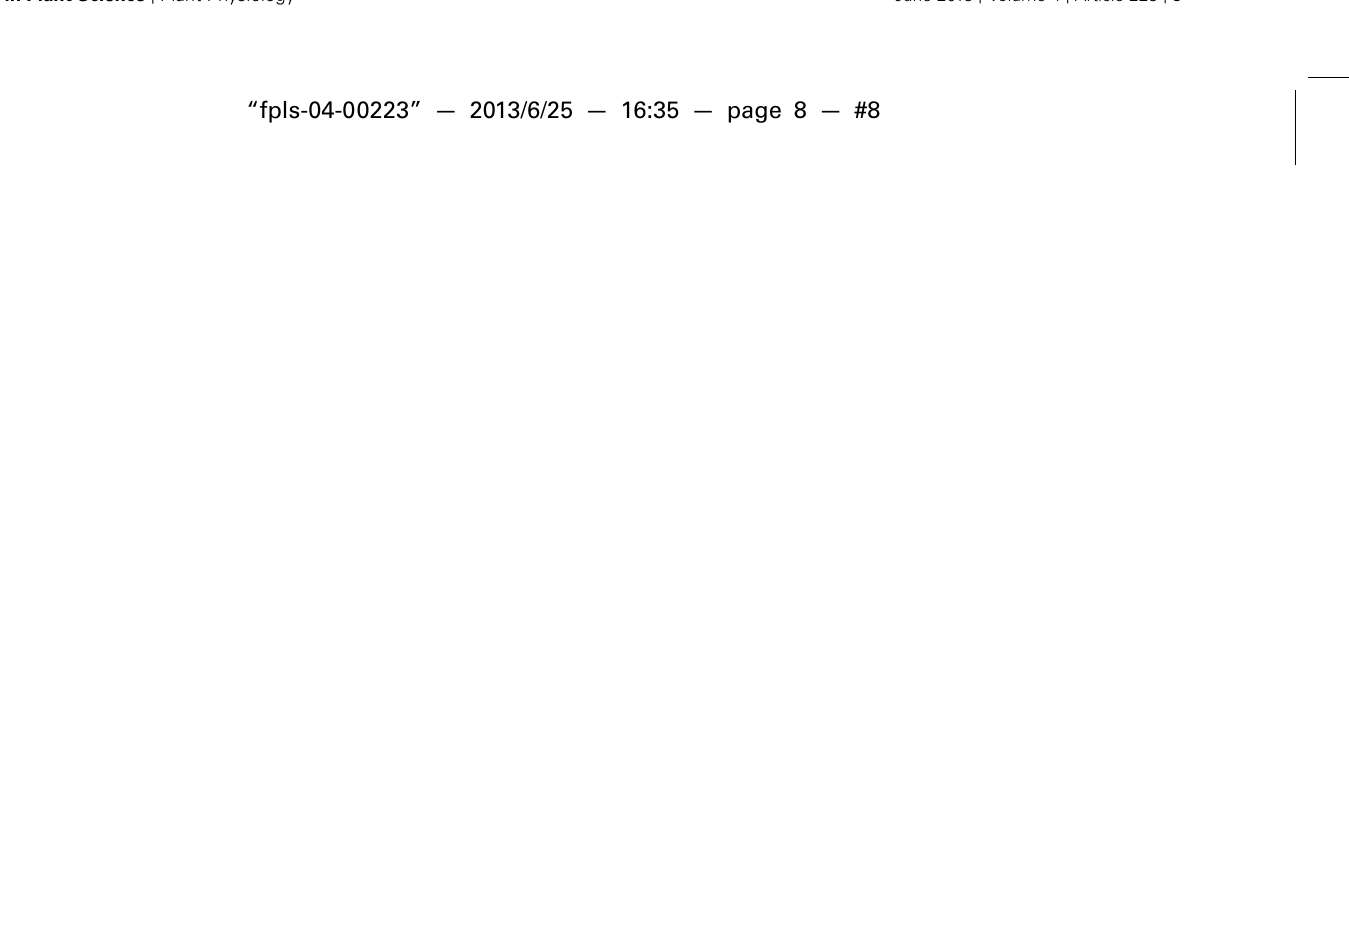
measured relative to SbEF-1 α . Organs examined were the Rachis and Spikelet as well as the upper portion of the flag internode (Upper flag inter). Columns with vertical bars represent mean ± SE from five biological